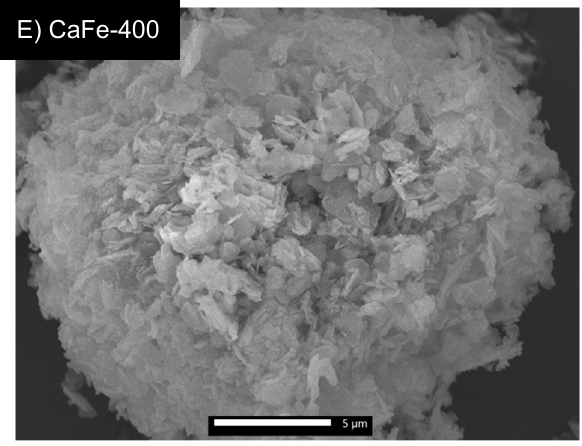
Figure 9. SEM micrographs of samples calcined at 400 ◦ C. ( A , B ) show micrographs of CaAl-400 sample. ( C ) belongs to CaAl 0.80 Fe 0.20 -400 sample and ( D , E ) show SEM micrographs of CaFe-400 sample.